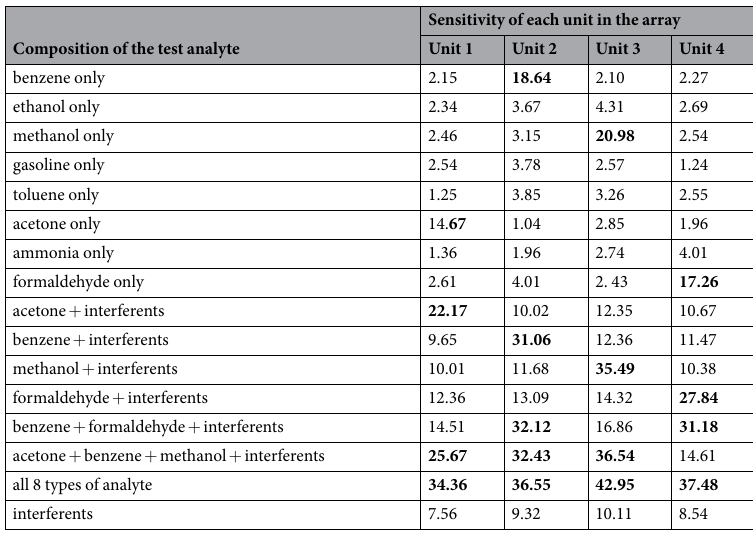
Table 1. The compositions of the test analytes and the sensitivity of the 4 units in each test.